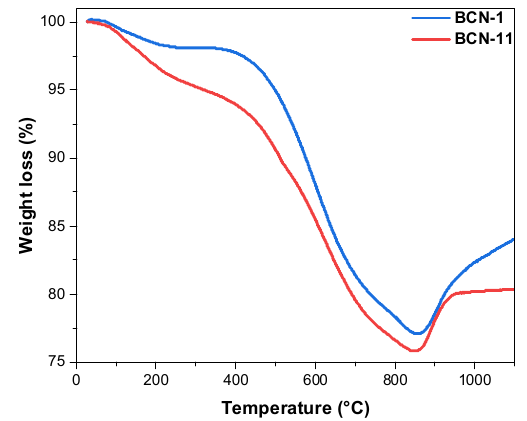
Figure 3. TGA curves of BCN-1 and BCN-11. X-ray diffraction patterns of BCN-1 and BCN-11 (Figure 4) show two broad diffraction peaks. The first one is centered at around 24 ◦ and the second at around 43 ◦ . These peaks positions are characteristics of both hexagonal BCN and hexagonal BN despite the limited crystallinity of the samples. The two peaks correspond to (002) and (100) reflection planes, respectively. In comparison with h-BN, the BCN samples show a general broadening of diffraction planes as well as a shift in the (002) plane towards lower 2 θ values (centered at 26.3 ◦ for BCN-1 and 24.9 ◦ for BCN-11) indicating that the doping of carbon produces structural defects and an increase in interlayer spacing [24,45,46]. The 100 diffraction